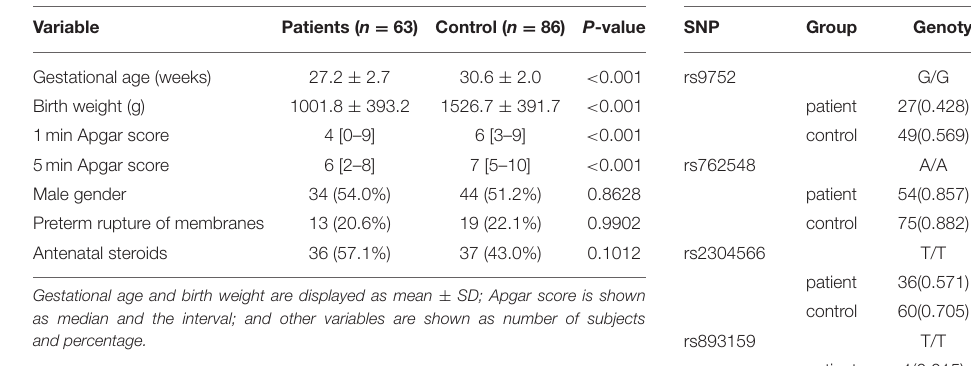
TABLE 2 | Characterization of enrolled subjects. TABLE 3 | Comparison of gene polymorphisms (SNPs) in the SFTPB